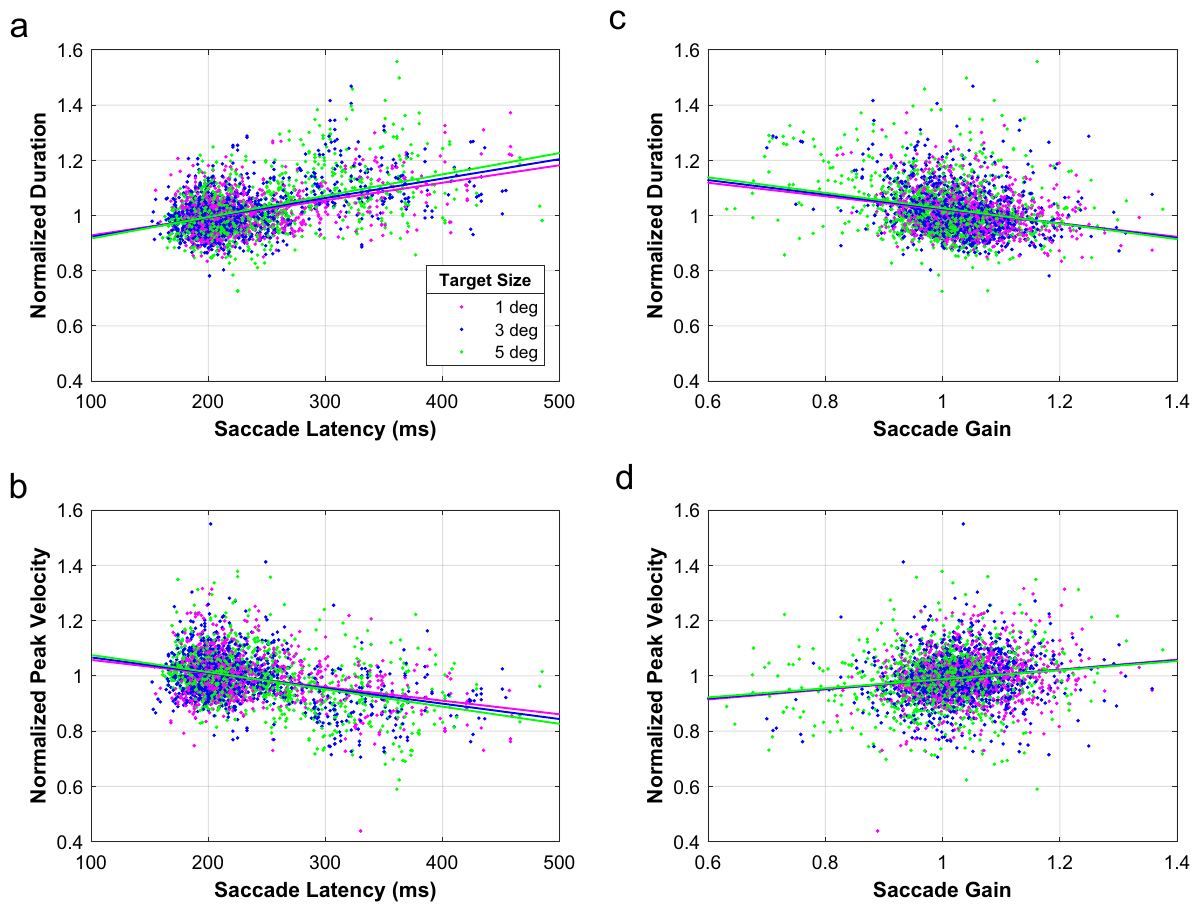
Figure 4. Normalized duration and peak velocity. Data in this plot are from the same individual (Subject Number 4) as in Fig. 3, and pooled across target location and recorded eye. The data are normalized with respect to the main sequence for normometric (i.e., 0.9 > gain > 1.1) saccades towards 1° wide targets with regular (< 250 ms) latencies (i.e., pink main sequence curves in Fig. 3). ( a , b ) Normalized duration and the normalized peak velocity as a function of the latency for each of the three target sizes (color coded). ( c , d ) Same kinematics data as in ( a ) and ( b ) but now plotted as a function of saccade